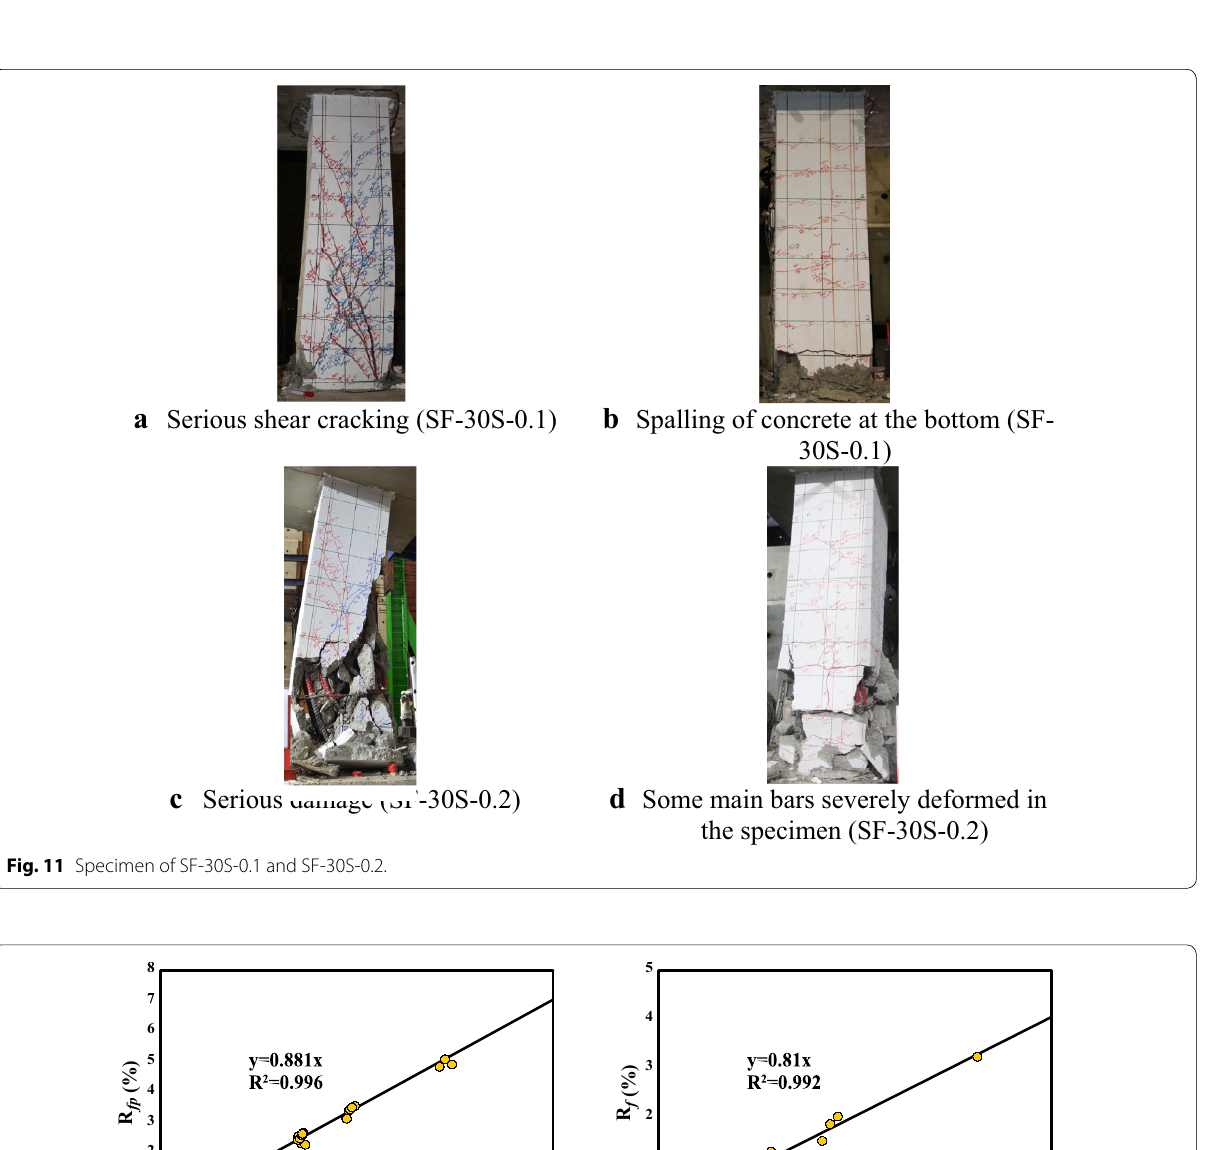
Fig. 12 Flexural deformation of specimens under the